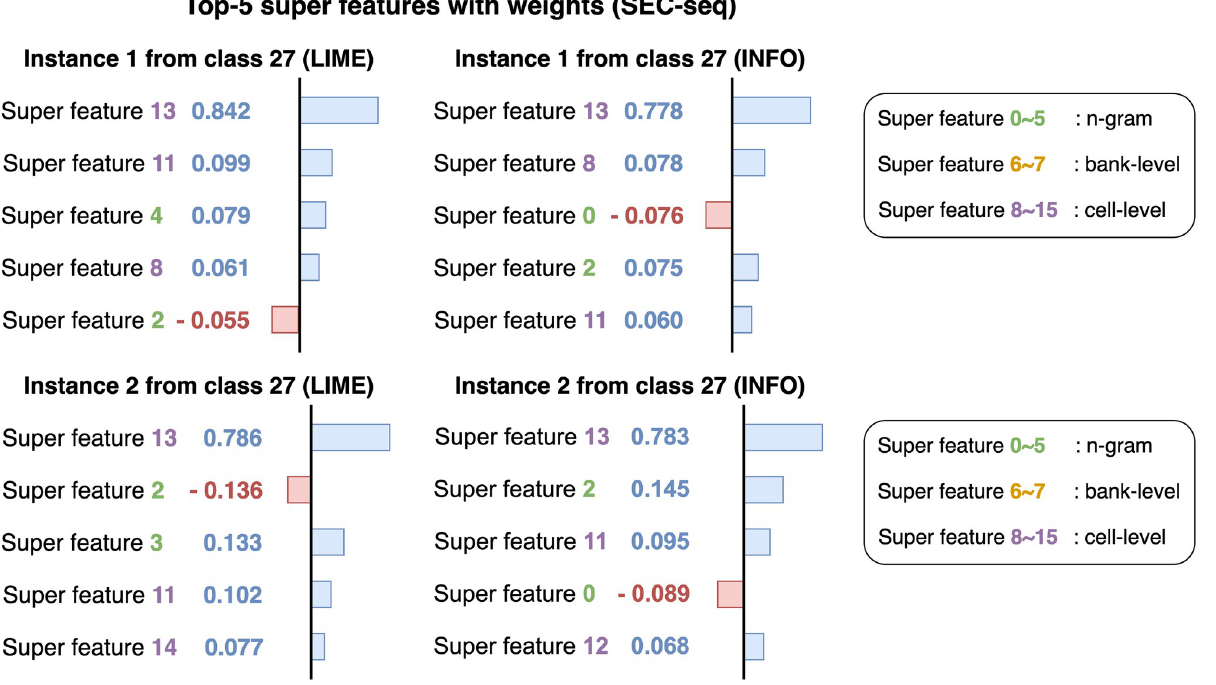
Fig 10. Comparison of interpreting two instances from SEC-seq dataset using LIME and INFO. Both instances are correctly classified as class 27. Note that super features of two instances generated from LIME are different resulting in inconsistent interpretations while INFO utilizes the same super features over all instances.